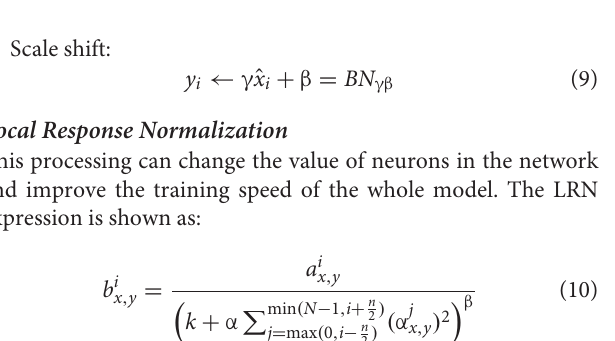
FIGURE 4 | Visual Geometry Group (VGG)-19